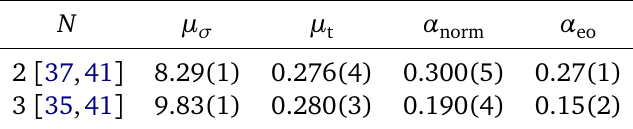
Table 2: Monte Carlo results for surface criticality in the classical O ( N ) model. The values of µ σ and µ are from the recent study [ 41 ] of the normal boundary univer- t sality class, and α is obtained from these using (32). α is from the studies of norm eo = 0), where it was extracted from the boundary the extraordinary phase (with h 1 correlation function (33) [ 35,37 ]